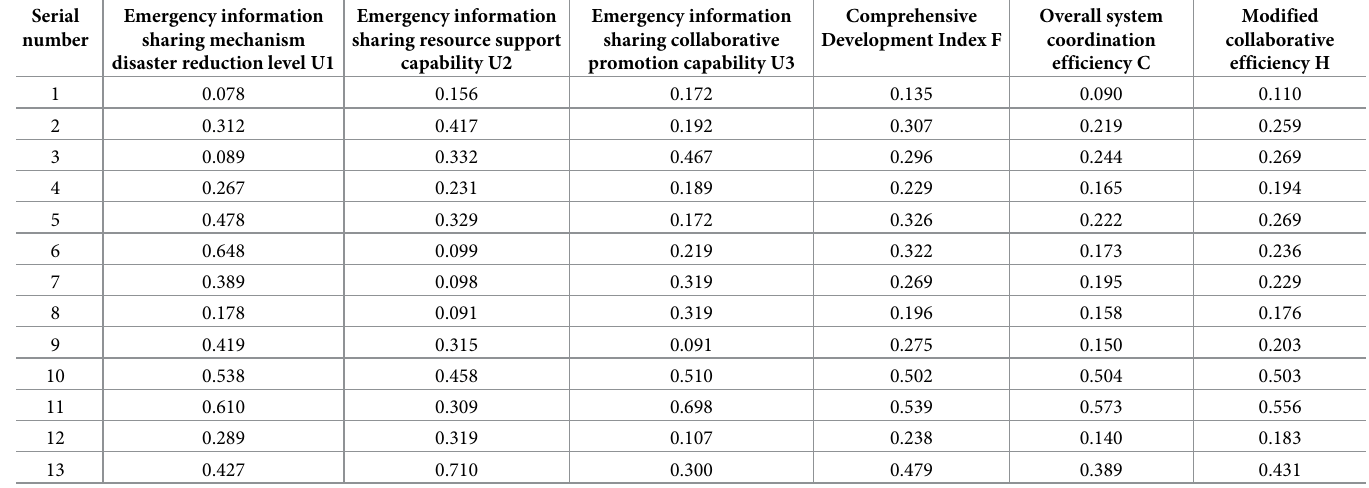
Table 4. Collaborative efficiency of emergency information sharing for 13 disaster